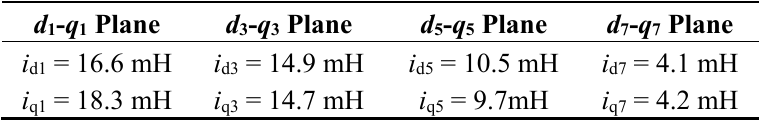
Table 3. Inductance